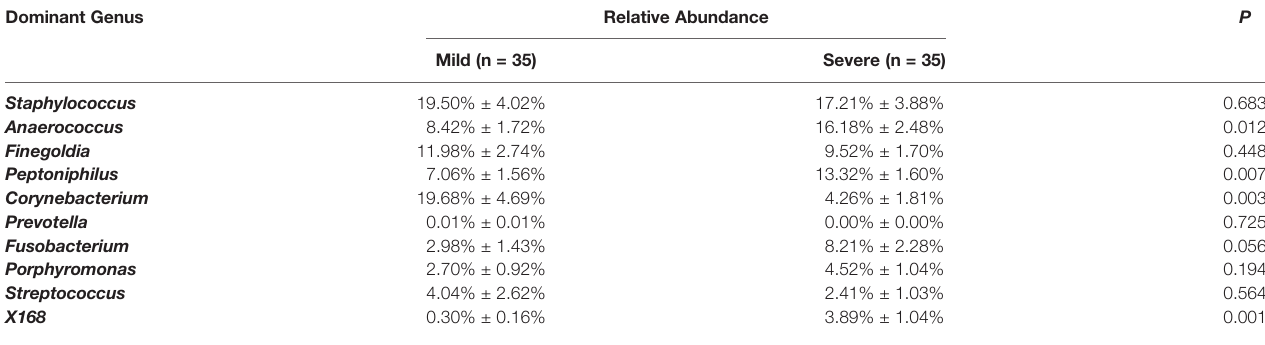
TABLE 2 | Comparison of relative abundance of the 10 dominant dermic microbes in mild and severe paronychia. Dominant